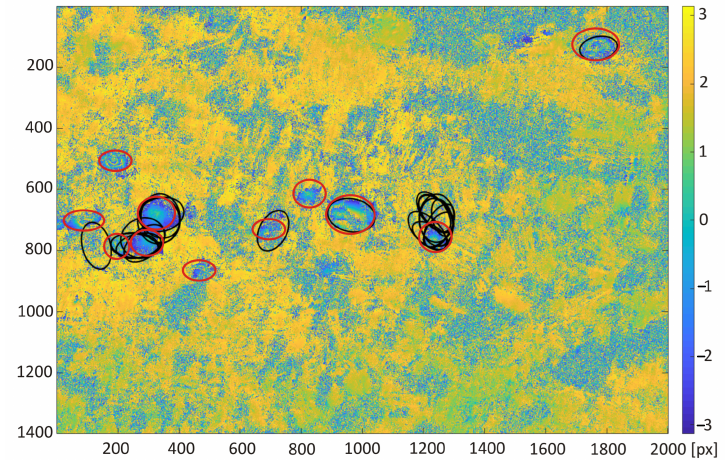
Figure 14. Interferogram of the first area computed from pictures recorded by Sentinel-1 on the 10th and 22nd of October 2016. Red ellipses are the subsidence area marked by experts; black ellipses were detected by Hough transform.